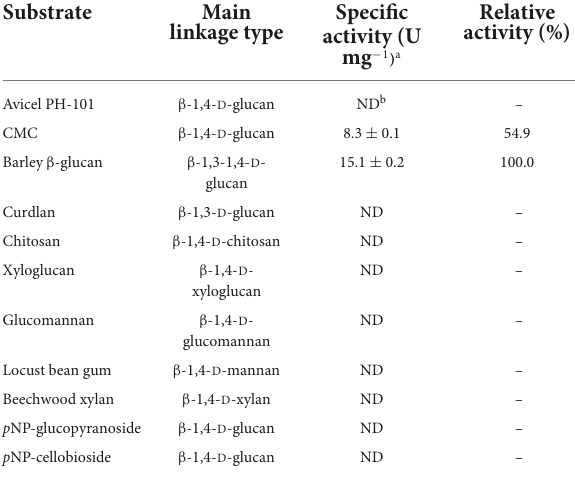
TABLE 2 Degradation activity of recombinant endo- β -1,4-glucanase (rGluL) toward different substrates. Substrate